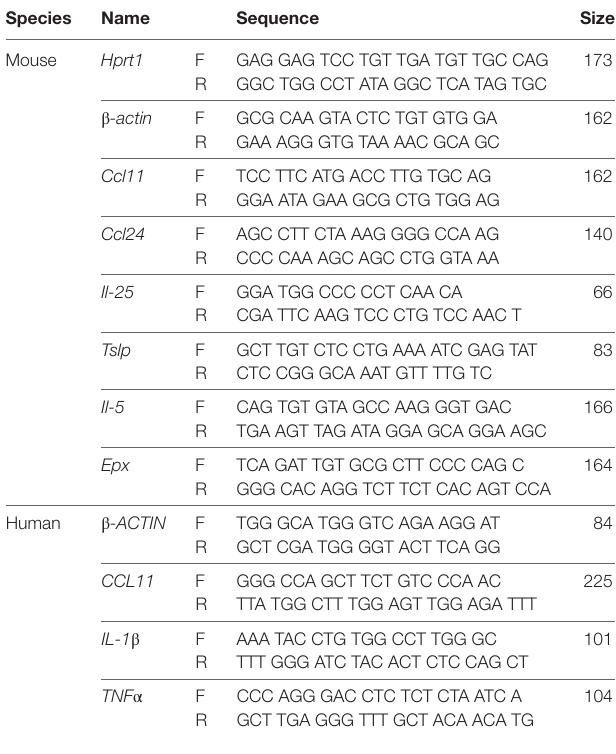
TaBle 1 | List of primers used for real-time RT-PCR.